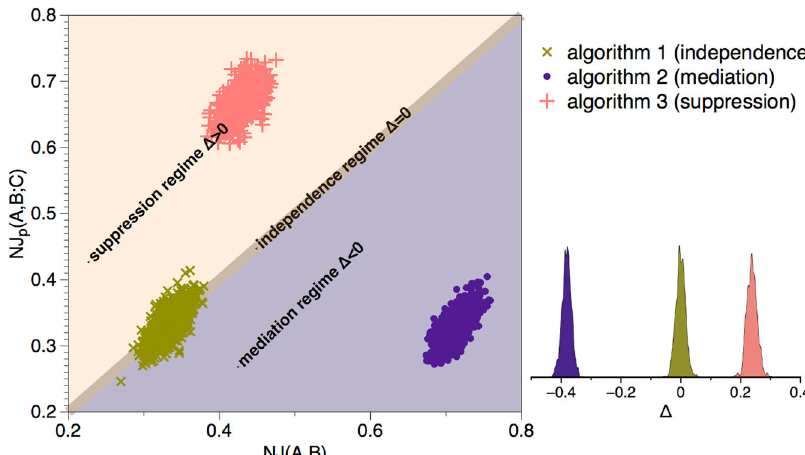
Fig. 1 Pure models of independency, mediation and suppression. We plot the partial network — Jaccard index NJ p ð A ; B ; C Þ vs the network — Jaccard index NJ ð A ; B Þ of networks A and B conditioned on a third network C , calculated on 1000 realisations of triplets of networks of N = 50 nodes wired such that C plays no effect (green crosses), plays a mediating effect (violet dots) or a suppression effect (red crosses) in the relation between A and B . These interactions are constructed using the generative models described in Algorithms 1, 2 and 3 ( p = 0.5 in every case, and q = 1). For completeness, we also depict the histograms P ( Δ ) of Jaccard net differences Δ , which certify that these algorithms generate networks where C play an independent role ( Δ ≈ 0), a mediating role ( Δ < 0) or a suppressing role ( Δ >